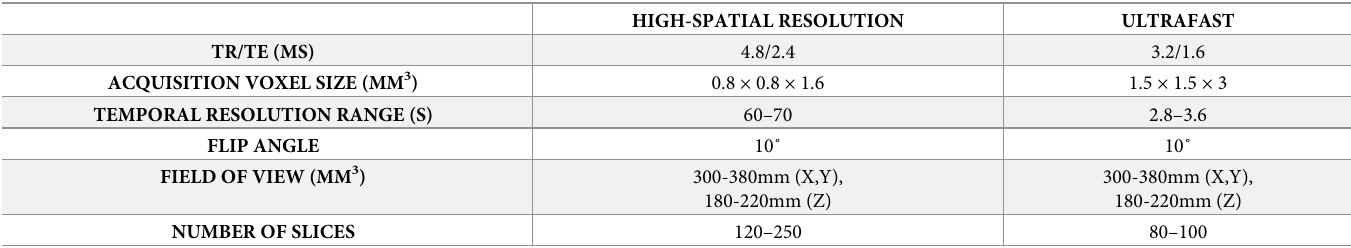
Table 1. Scan parameters of the source MR image datasets.